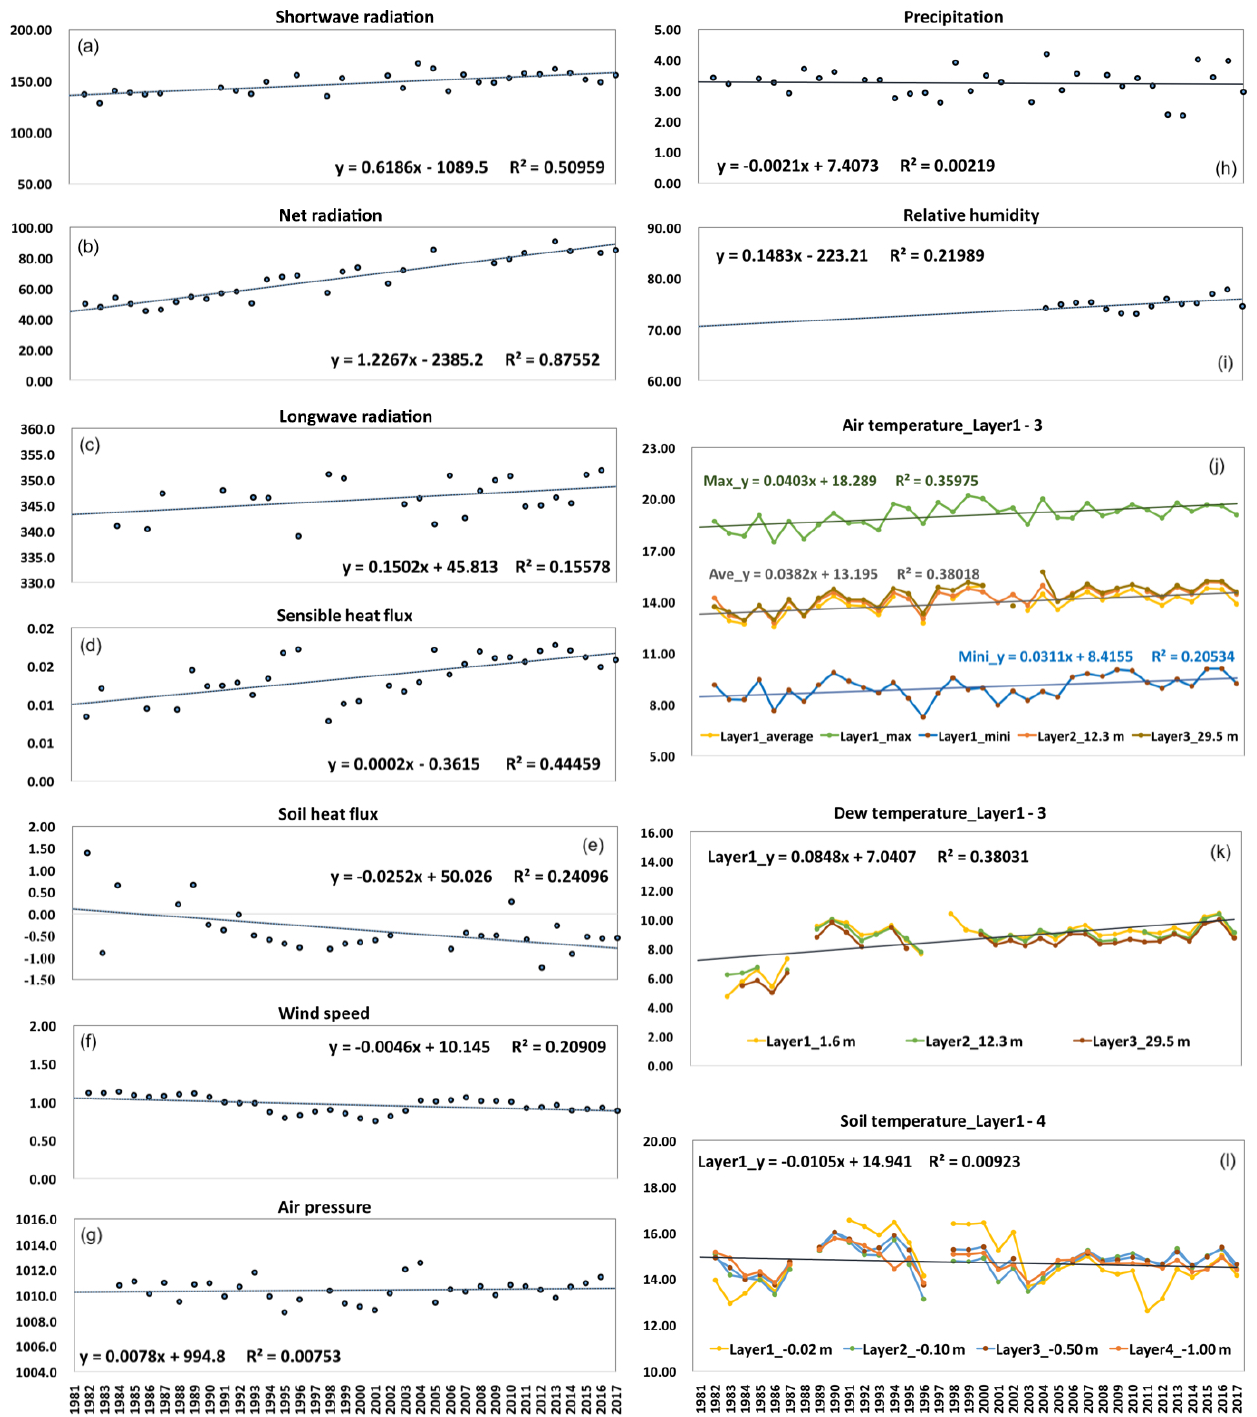
Figure 5. Annual average values of the observational database showing the (a) shortwave radiation (Wm − 2 ), (b) net radiation (Wm − 2 ), (c) longwave radiation (Wm − 2 ), (d) sensible heat flux ( ◦ Cms − 1 ), (e) soil heat flux (Wm − 2 ), (f) wind speed (ms − 1 ), (g) air pressure (hPa), (h) precipitation (mmday − 1 ), (i) relative humidity (%), (j) average, maximum and minimum air temperature ( ◦ C) at a height of 1.6m, with the average values at the heights of 12.3 and 29.5m, (k) dew point temperature ( ◦ C) at heights of 1.6, 12.3 and 29.5m, and (l) soil temperature ( ◦ C) at the depths of 0.02, 0.1, 0.5 and 1m.